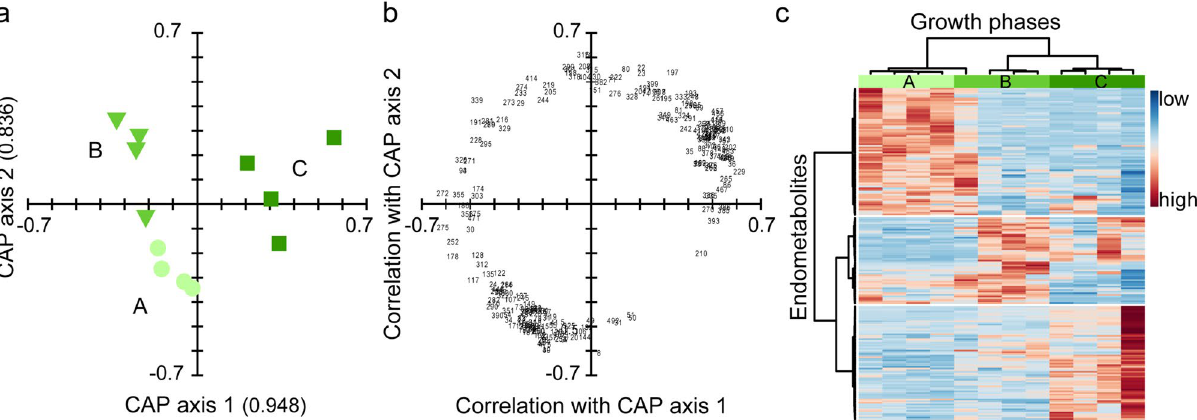
Figure 2. Endometabolic changes of Phaeocystis pouchetii AJ01 during growth in laboratory batch cultures (n = 4). Separation is based on canonical analysis of principal coordinates (CAP); axis eigenvalues are given in parentheses. ( a ) Score plot of the growth phases: exponential phase (’exp’, bright green circle), early stationary phase (’e.stat’, green triangle), late stationary phase (’l.stat’, dark green square). ( b ) Loading plot (scaled to score plot) of correlated endometabolites (> 0.708) depicted with their identifier as tabulated in the Supplementary Table S6. ( c ) Heat map of correlated endometabolites (analyte peak area/peak sum) indicating low (blue) or high (red) relative concentrations in the growth phases. Metabolites and samples are clustered hierarchically for better visualization using the Pearson distance measure and Ward cluster